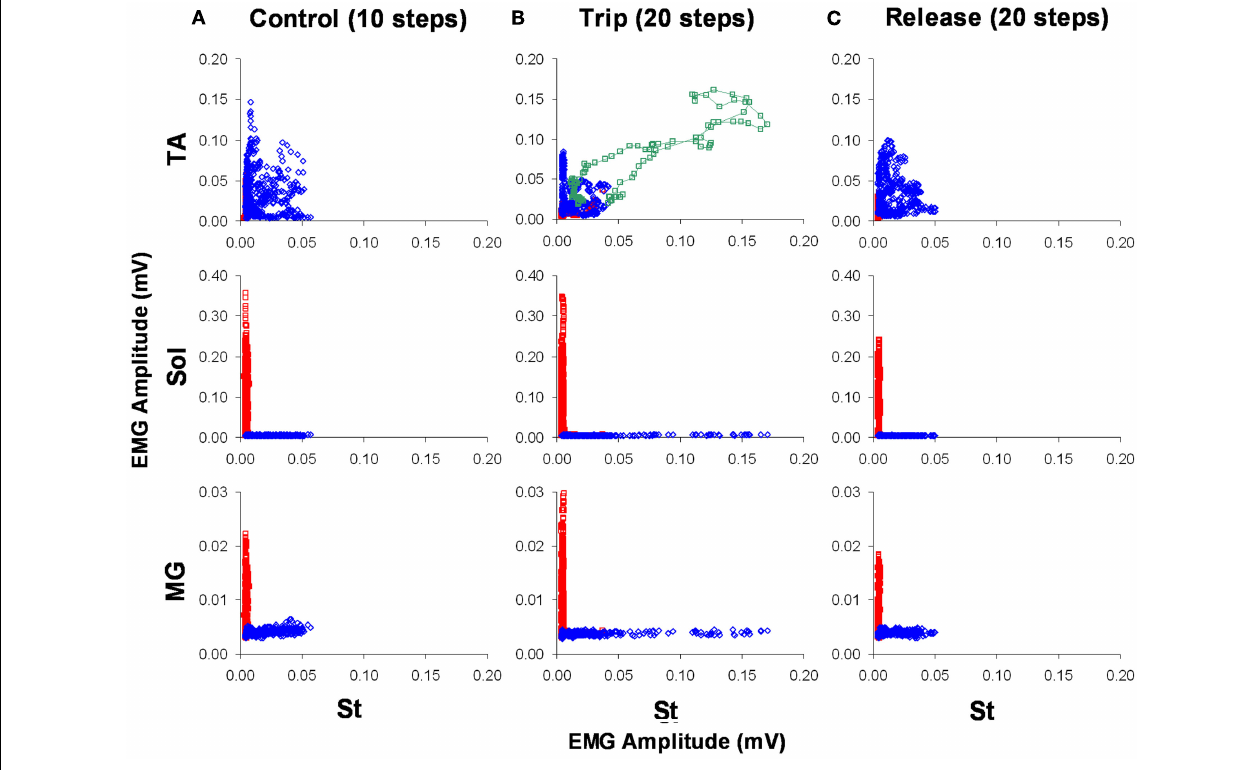
FIGURE 10 |The level of activation of theTA, Sol, and MG vs. the St for a sequence of 10 control (A), 20 trip (B), and 20 release steps (C) is shown. Blue and red represent the swing and stance phases of the step cycle, respectively.The green symbols in (B) represent the co-activation